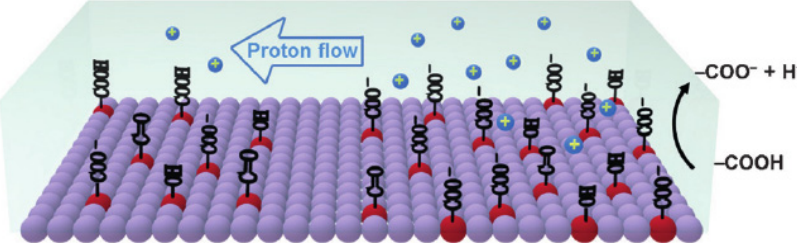
Figure 15. The proton-transfer mechanism in functionalized porous carbon film. Reprinted with permission from [153]. Copyright 2016, Wiley Online Library.